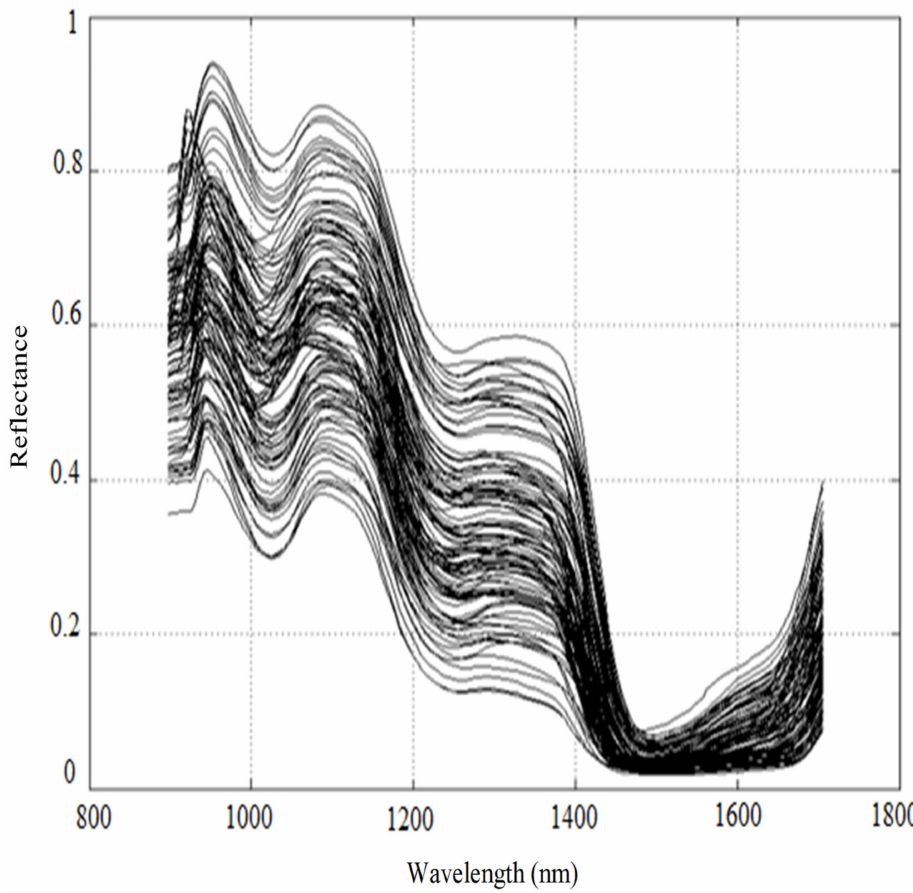
Figure 10. NIR spectral reflectance values of different homogeneous snow